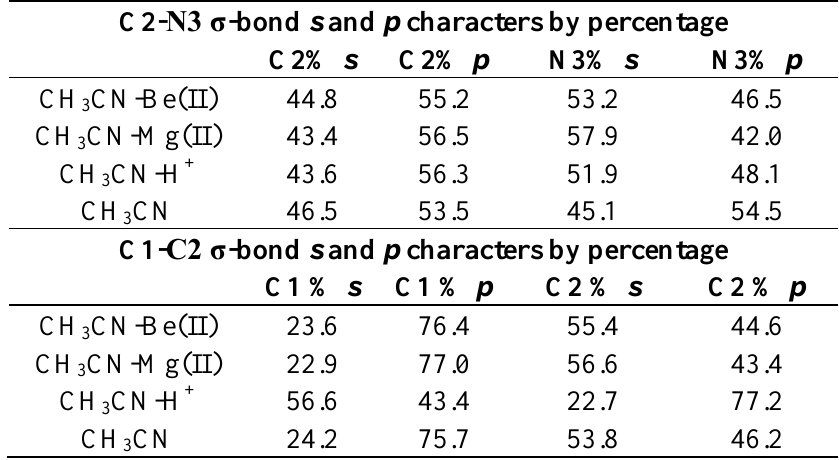
Table 9. s versus p characters in C2-N3 and C1-C2 σ -bonds in acetonitrile and its Mg(II), Be(II) and H complexes †